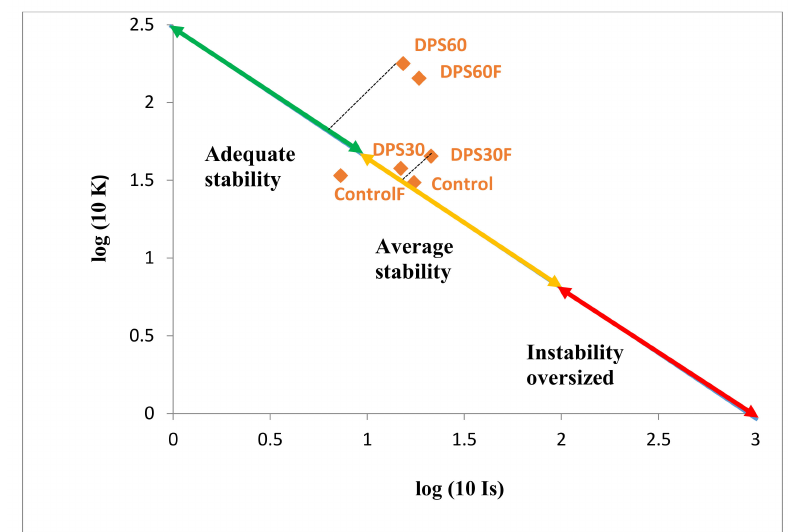
Figure 3. E ff ect of di ff erent rates of deinking paper sludge (DPS) on the structural stability of a Calcaric Fluvisol soil in the presence or absence of nitrogen fertilizer (ammonium nitrate at 150 kg ha − 1 ) after two successive annual amendments. Treatments: control, no DPS; DPS30, DPS at 30 Mg ha − 1 ; DPS60, DPS at 60 Mg ha − 1 ; controlF, control with fertilizer; DPS30F, DPS30 with fertilizer; DPS60F, DPS60 with fertilizer.